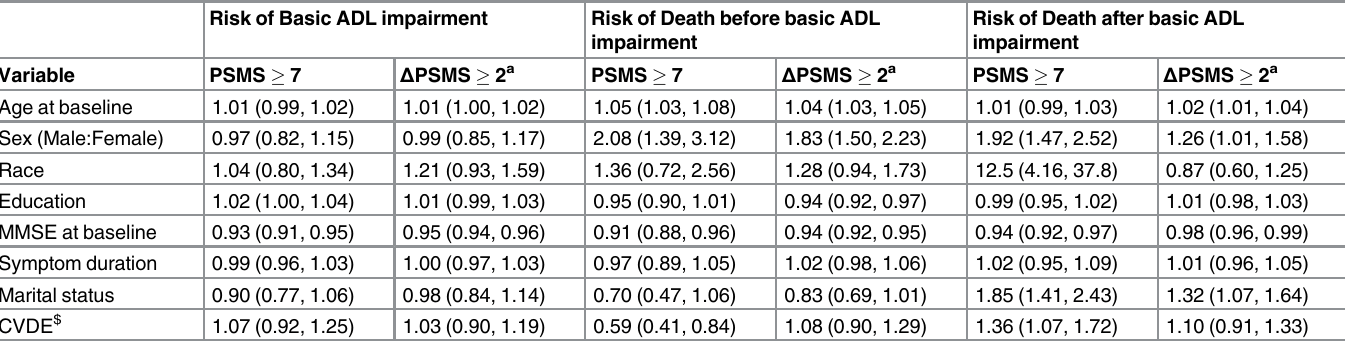
Table 3. Hazard ratios (95% confidence intervals) in the multistate model for predicting basic ADL impairment or death. Risk of Basic ADL